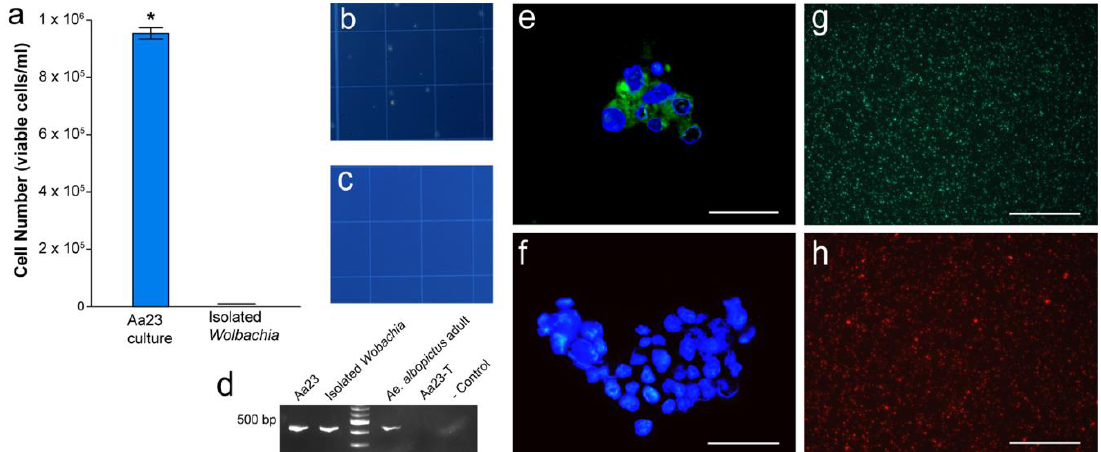
Figure 1. (A) Aa23 cell counts prior to Wolbachia isolation procedures. * above the bars represents a significant difference (t-test, p < 0.05), (B) pre- and (C) post- Wolbachia isolation using Trypan Blue stain, (D) Polymerase chain reaction (PCR) confirmation of Wolbachia infections in Aa23 cells and isolations, (E) Fluorescent in-situ hybridization (FISH) staining of Aa23 cells confirming Wolbachia infection, (F) FISH staining of Aa23-T aposymbiotic cells showing the absence of a Wolbachia infection, and (G) Baclight LIVE/DEAD™ staining of Wolbachia immediately after isolation procedures, and (H) Baclight LIVE/DEAD™ staining of heat killed Wolbachia . White scale bars represent 50